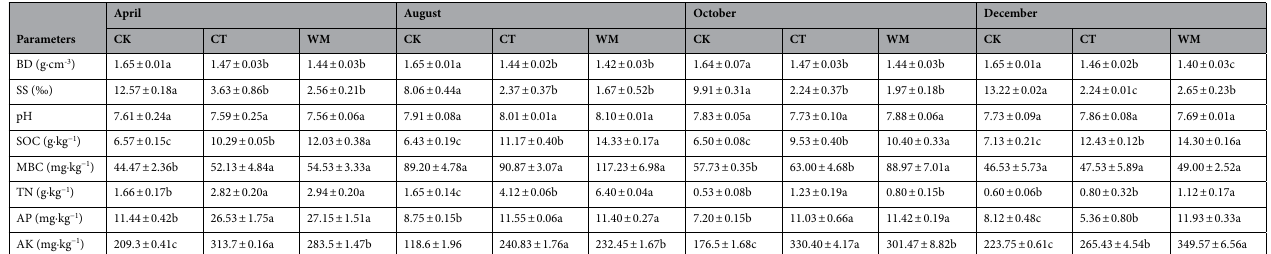
Table 1. Changes in the soil physical and chemical properties of different study sites at the 0–10 cm depth in April, August, October and December. K, natural coastal wetland; CT, cotton mono-cropping farmland; WM, wheat–maize rotation cropping farmland; BD, bulk density; SS, soluble salts; SOC, soil organic carbon; MBC, microbial biomass carbon; TN, total nitrogen; AP, available phosphorus; and AK, available potassium. Values are represented as means ± SD. Different letters in the same column indicate significant variance by T-test at p <